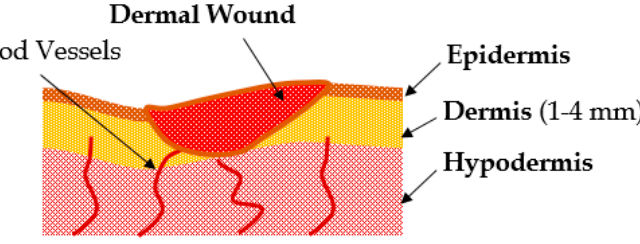
Figure 1. Schematic of different layers of the skin with a dermal wound.